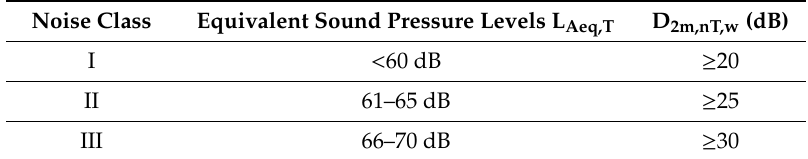
Table 2. Equivalent sound pressure levels L Aeq,T , incidents on the façades of buildings for each noise class